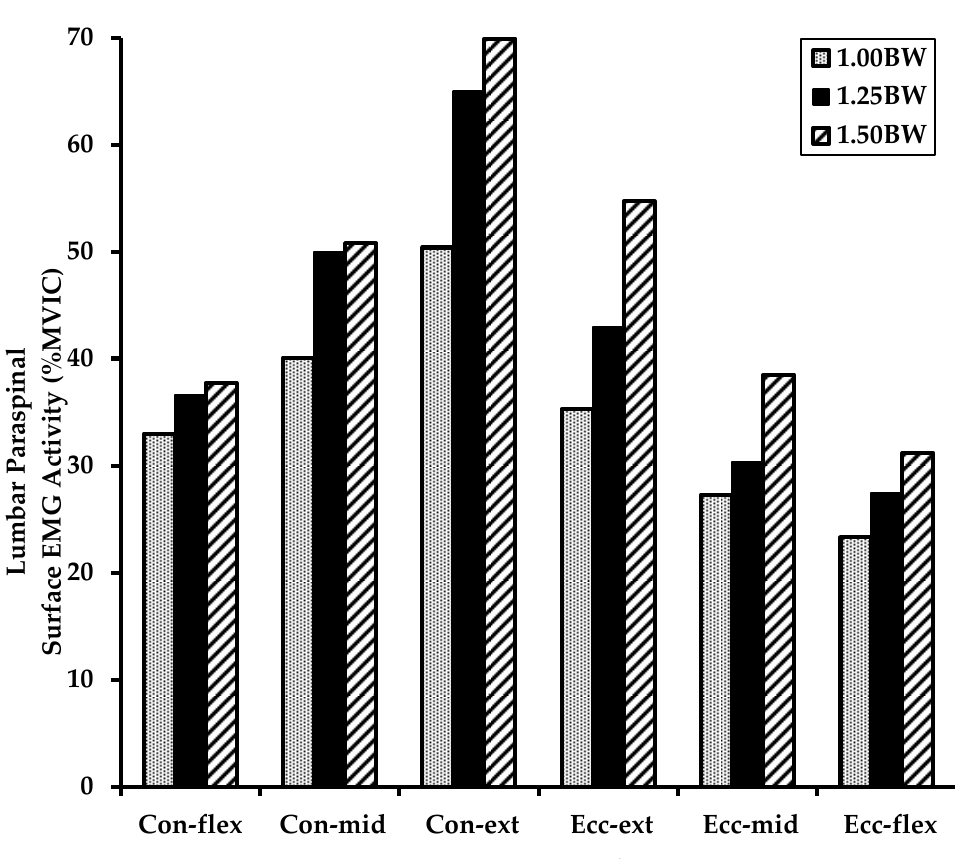
Figure 3. Graph of normalized lumbar extensor muscle surface EMG activity (in % MVIC) during dynamic exercise on a home back extension exercise device depicted by exercise load, phase of movement, and position in range of motion. Key: Mean values in % Maximum Voluntary Isometric Contraction (MVIC), BW = Bodyweight, Con = Concentric Phase, Ecc = Eccentric Phase, flex = flexion position in range of motion, mid = mid position, ext = extension position.